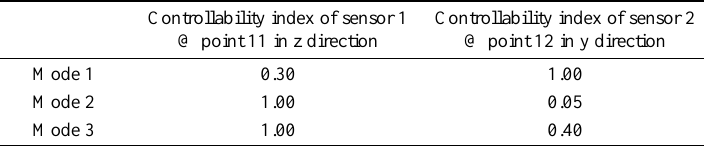
Calculated controllability index for the optimal sensor position